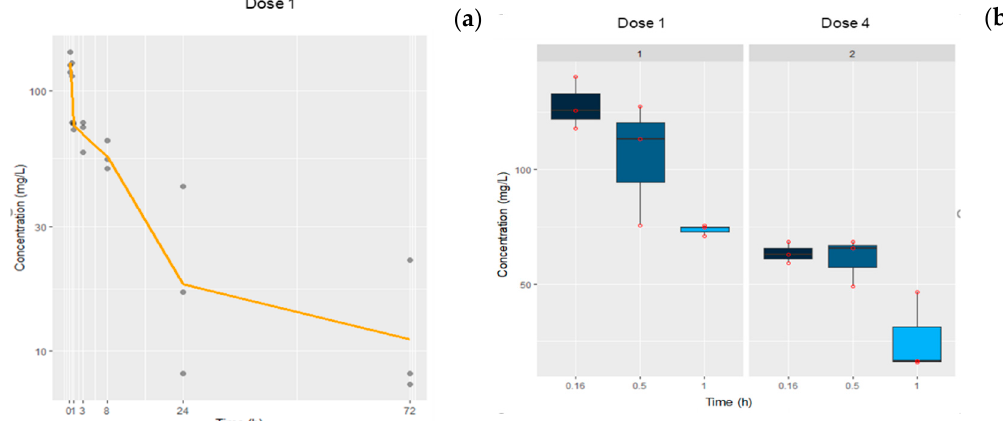
Figure 6. ( a ) Time course profile of a-PD-1 plasma concentrations collected from tumor-bearing mice at different time points after receiving the first dose ( n = 3/time point). Experimental data are represented by points and the solid line corresponds to the mean (left panel). ( b ) Box plots represent the plasma concentrations at 10, 30, and 60 min after the first and fourth administrations; symbols show the observed data (right panel). Table 6. Drug exposure expressed as AUC 0 −∞ after first dose administration and the parameters, t 1/2 , Cl, and V d , calculated by linear regression.